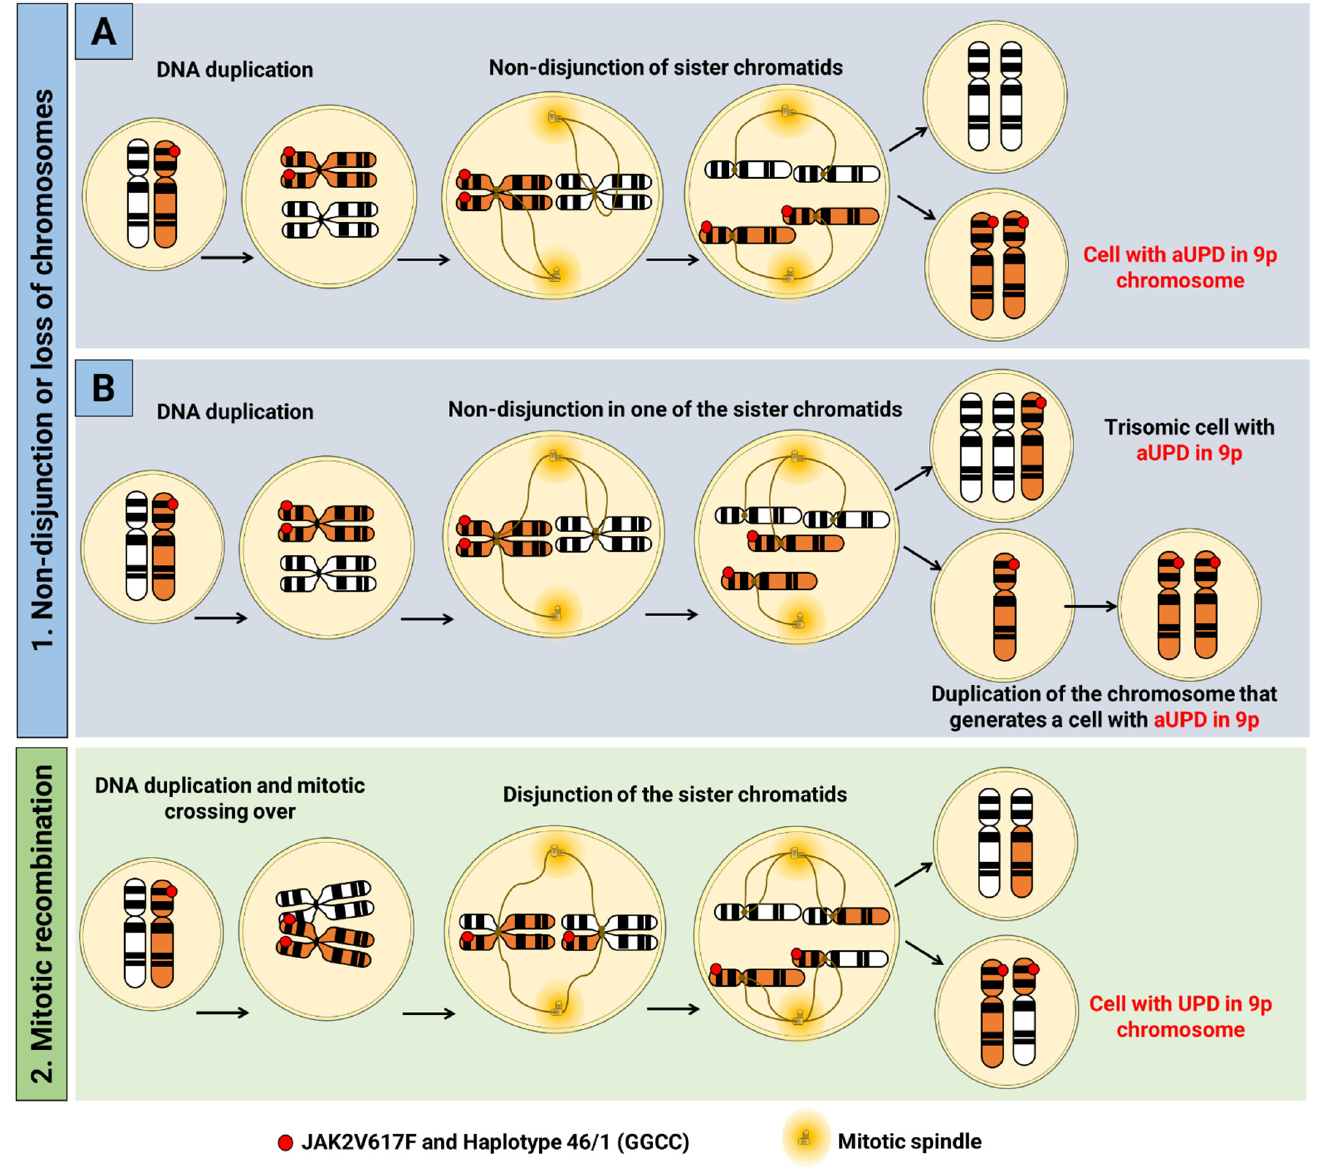
Figure 1. Mechanisms related to acquired uniparental disomy in hematopoietic pluripotent stem cells. This process can occur due to (1) ( A ) nondisjunction of sister chromatids or ( B ) delay in anaphase causing trisomy and monosomy of one of the chromosomes of the set, where in the cell with monosomy there is duplication of the remaining chromosome in the attempt to balance the loss of a chromosome, which results in two identical chromosomes in the same cell; or by (2) reciprocal exchange of chromosomal material during mitosis (mitotic recombination), such as chromatids, which generates several possible outcomes. In this example, applied to chromosome 9, the presence of the 46/1 haplotype and the JAK2V617F variant is illustrated, and is conditioned to the state of homozygosity.